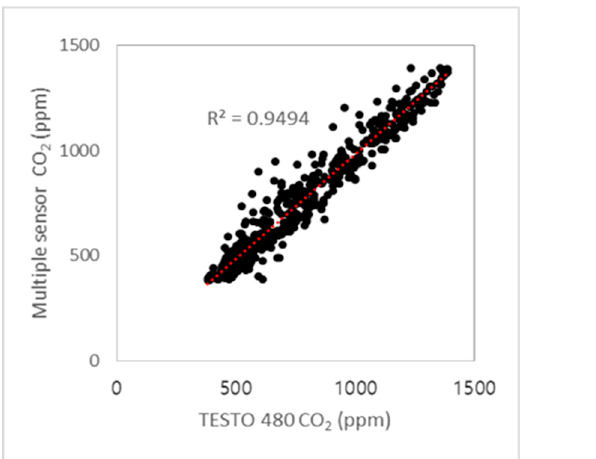
Figure 3. Measured CO 2 and PM 2.5 concentrations compared to the data from the TESTO 480 (CO 2 ) and the DustTrack II 8532 (PM 2.5 ) sensors, respectively.